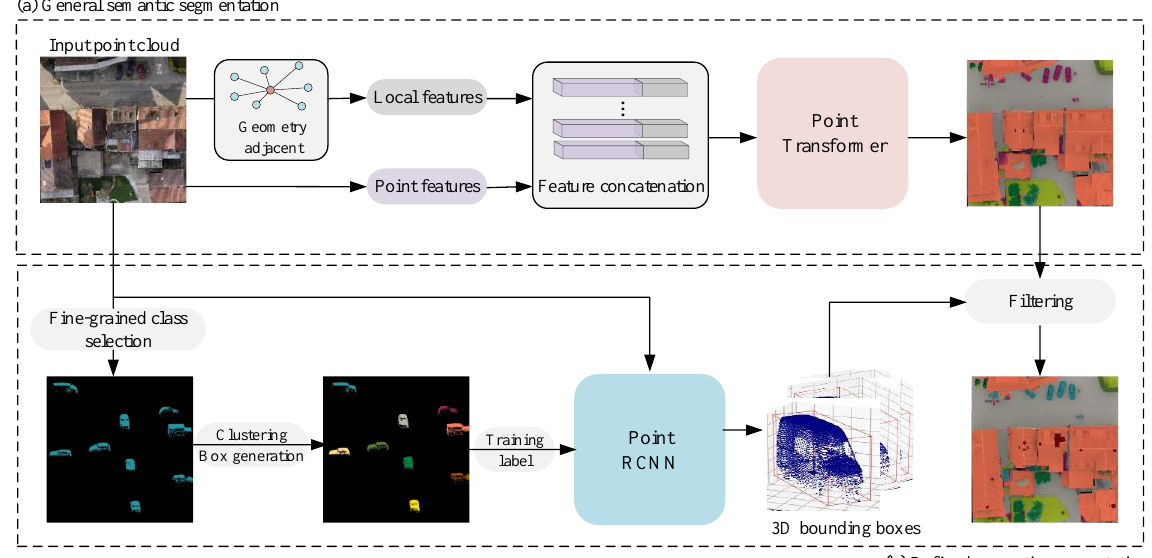
Figure 1. Structure of the proposed